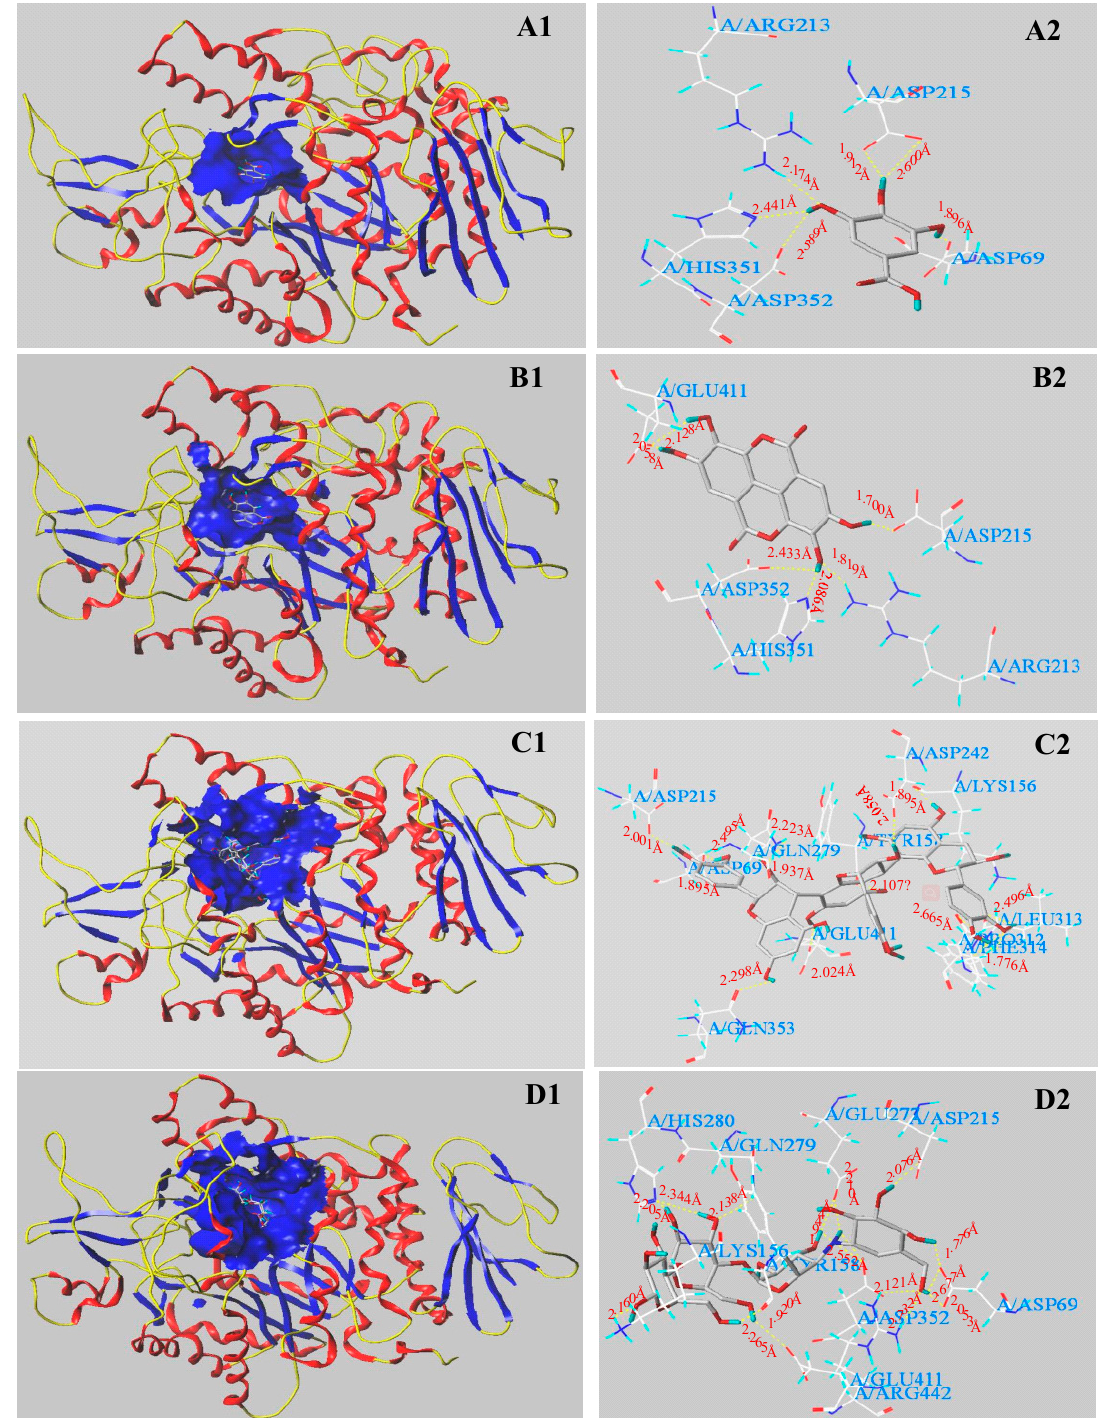
Figure 5. Molecular docking of the main three phenolic compounds and acarbose with the α -glucosidase. The 3D docking structures of three main phenolic compounds and acarbose were inserted into the hydrophobic cavity of the α -glucosidase (blue): gallic acid ( A1 ); ellagic acid ( B1 ); procyanidin C3 ( C1 ); acarbose ( D1 ). The conformation of active molecules interactions with amino acid residues in the active site of α -glucosidase: gallic acid (A2), ellagic acid (B2), procyanidin C3 (C2), and acarbose (D2) with residues in the active sites of the α -glucosidase, respectively. The dashed line stands for hydrogen bonds.